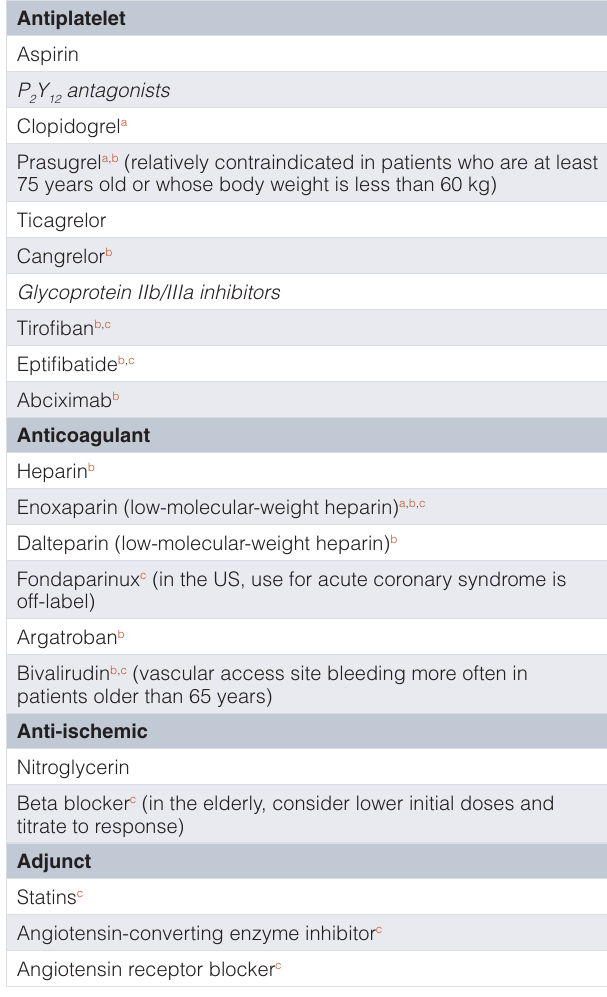
Table 1. Acute coronary syndrome